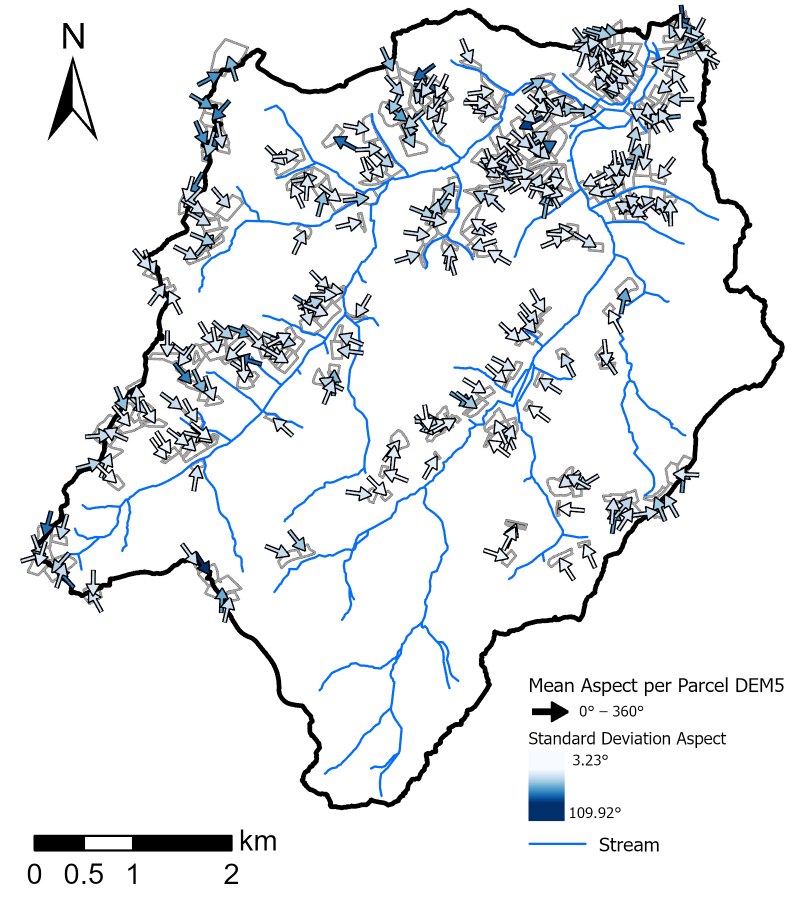
Figure 11. Mean aspect of DEM5 for masked arable land parcels including SD in relation to streams in the Fischbach catchment; data source: [29,30,40].